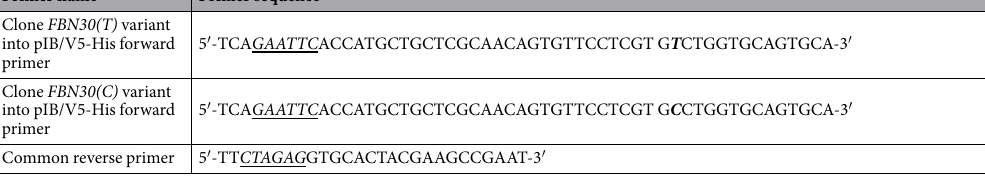
Table 1. PCR Primers. Note: The italic and underlined sequences denote restriction recognition sites. The italic and bold sequences denote difference. The primers were synthesized through Integrated DNA Technologies Inc.